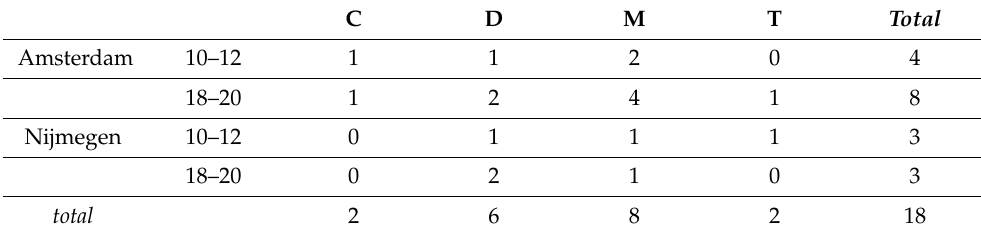
Table 5. Number of Speakers per subgroup with No substitute pronoun 27